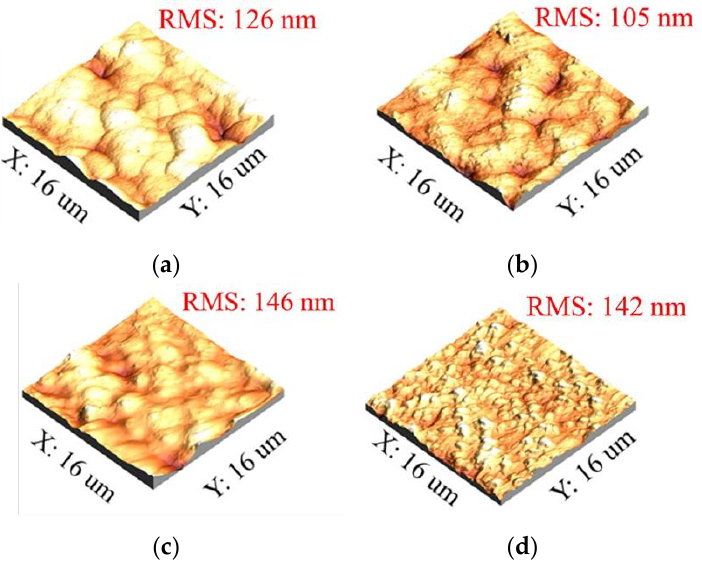
Figure 5. The roughness of the NPS-AuFON under different conditions. ( a ) Untreated; ( b ) CV 3 and 0.5 M H 2 SO 4 ; ( c ) CV 9 and 0.25 M H 2 SO 4 ; ( d ) CV 6 and 0.1 M H 2 SO 4 .